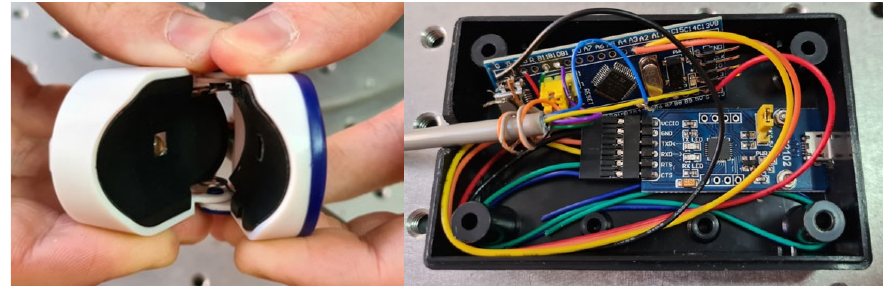
Figure 5. Wearable part of the sensor ( left ) and its control module ( right ).